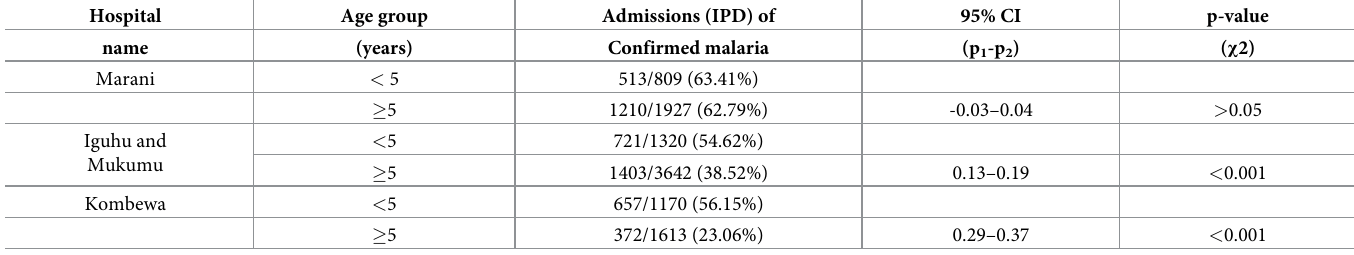
Table 4. Contribution of confirmed malaria cases to the inpatient admissions from three hospitals located in different malaria transmission settings of Western Kenya from June 2015 to August